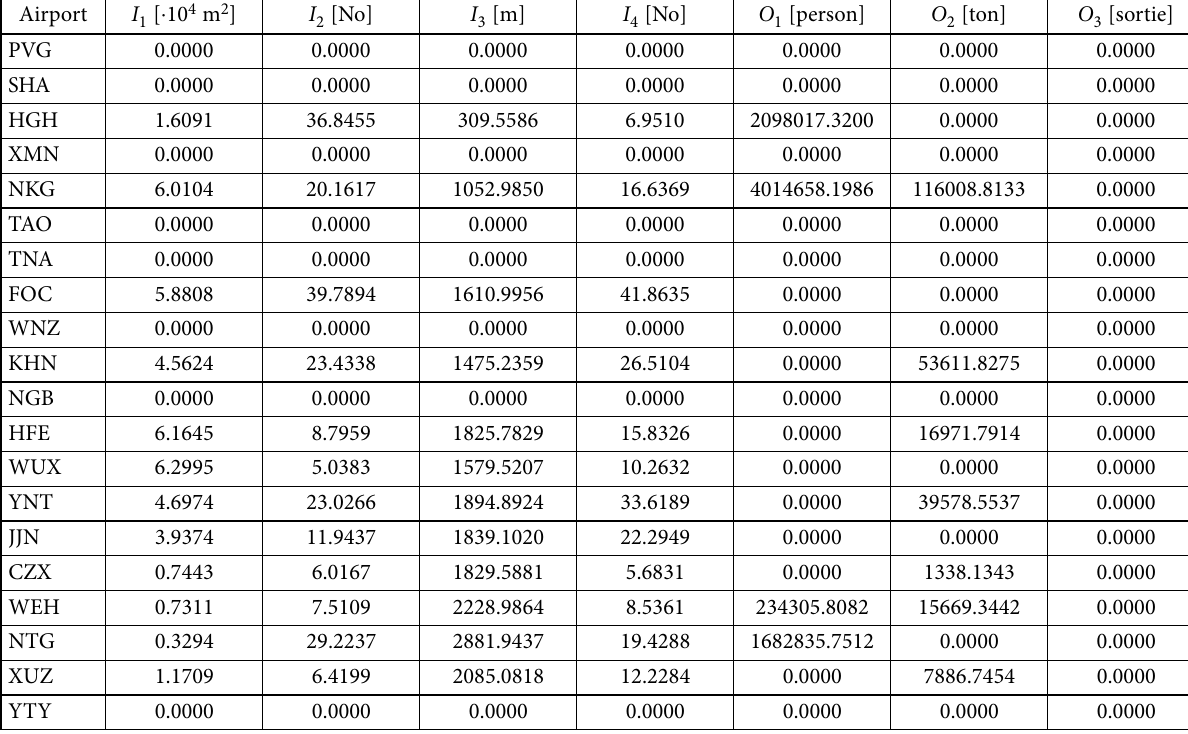
Table 7. Slacks of inputs and outputs of 20 airports in 2017 of the third stage